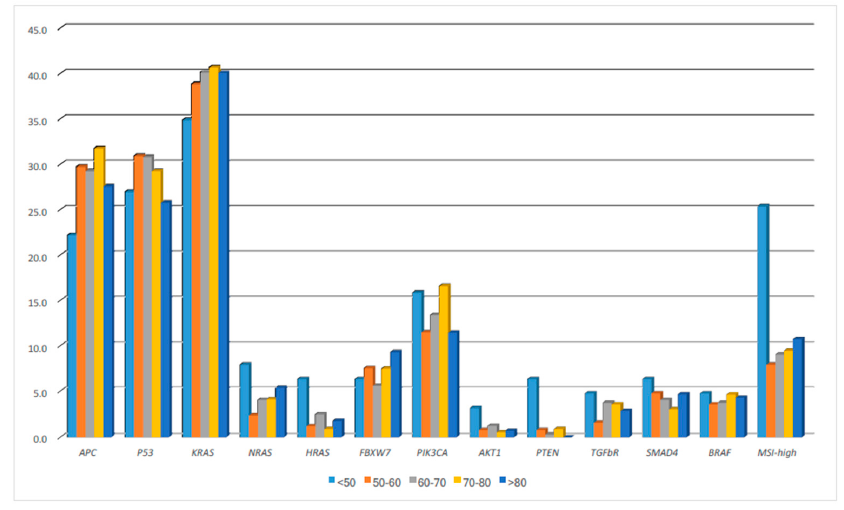
Figure 2. The distributions of molecular alterations in different age groups of colorectal cancer patients.